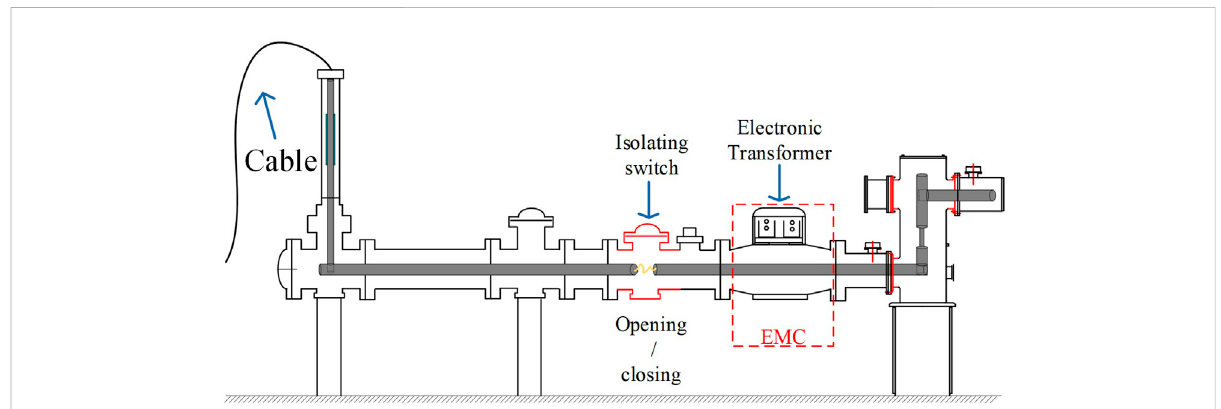
FIGURE 11 Layout of fi eld test platform device.